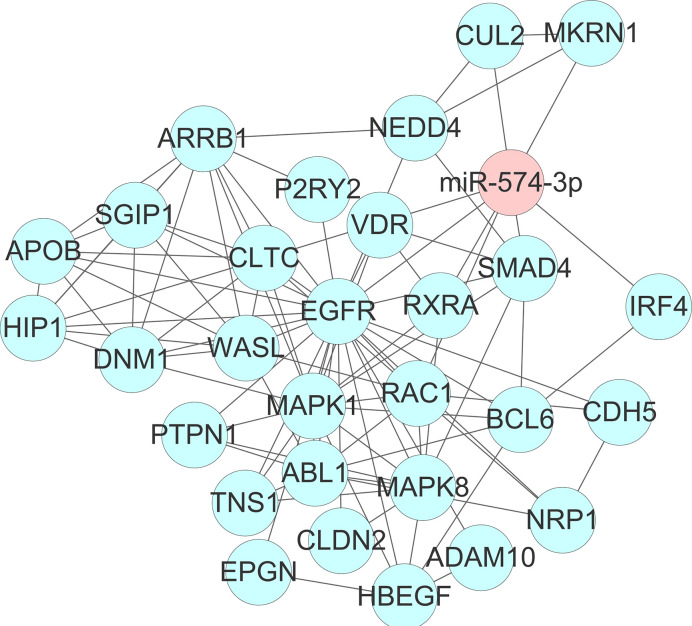
Identification of an important regulatory role for miR-574-3p-mediated signaling pathways (especially the EGFR/RAC1 pathway) in spinal chordoma by integrated analysis of both the miRNA-mRNA and protein-protein interaction networks data. miRNA, microRNA.